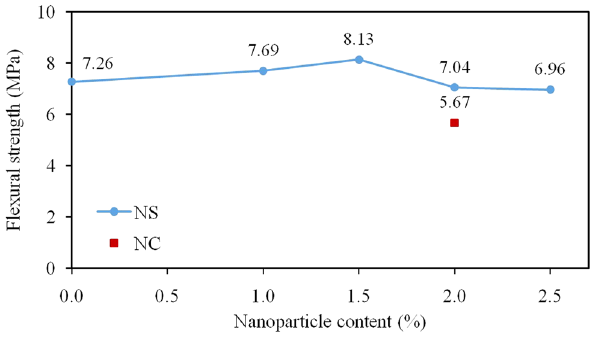
Figure 5: E ff ects of nanoparticle content and type on fl exural strength.